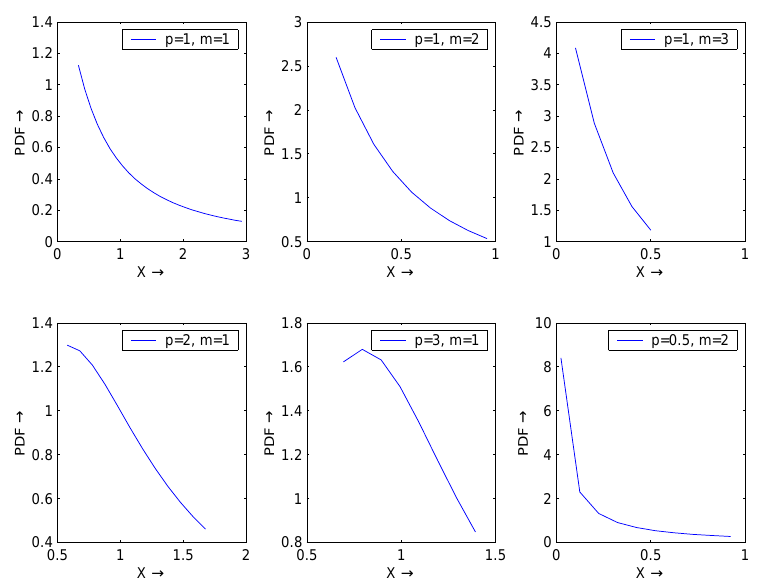
= 0.75 P = 0.25 Q . and